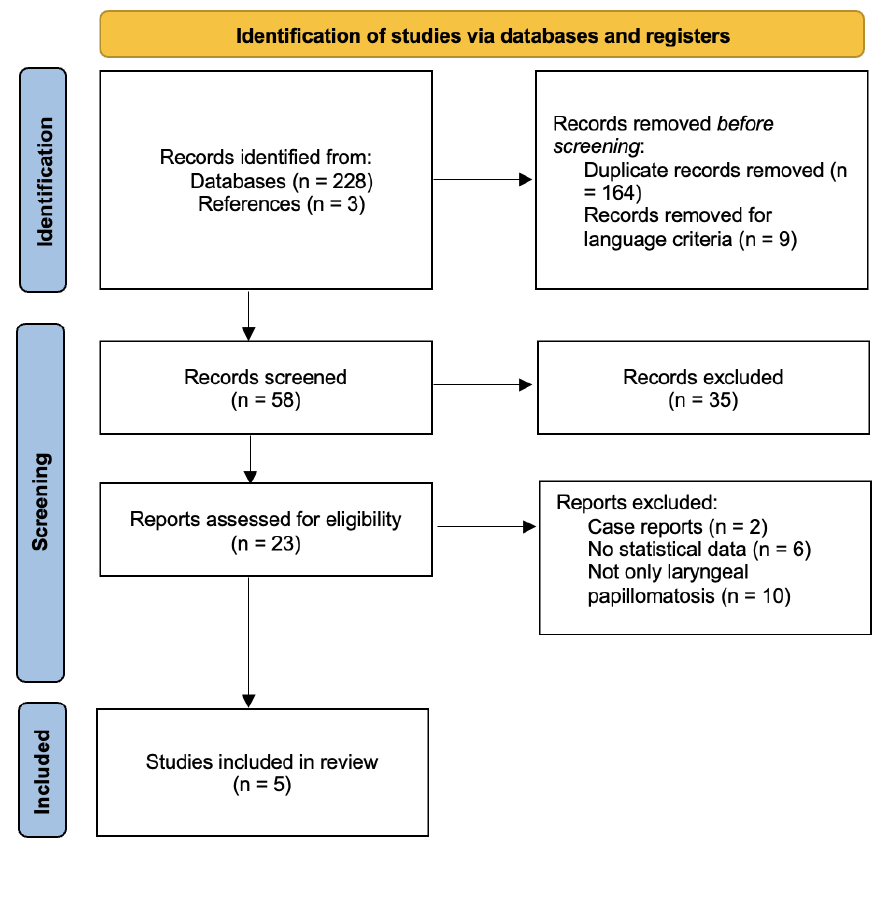
Figure 1. PRISMA 2020 Flow Diagram© of the study selection process from the literature search (from [9]).